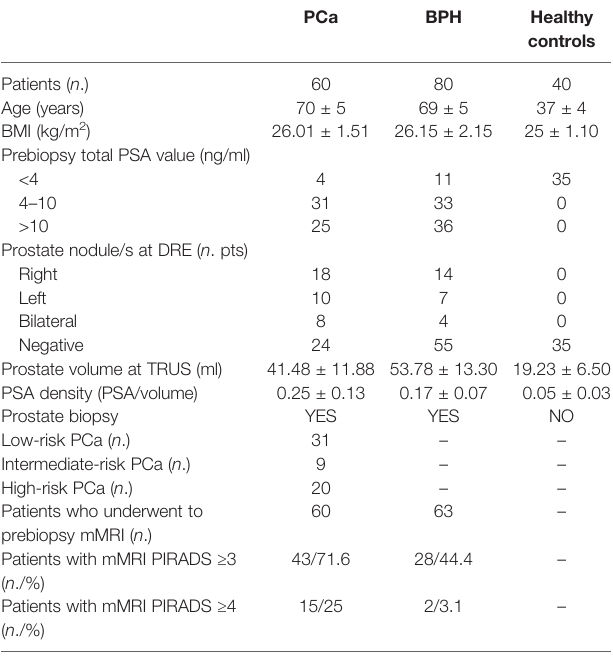
TABLE 5 | Median and MAD values of the bioimpedance features calculated on the right and left sides of the prostate in the both-sided prostate cancer group. p - Feature MEDIAN right MAD right MEDIAN left MAD left side side side side Value R